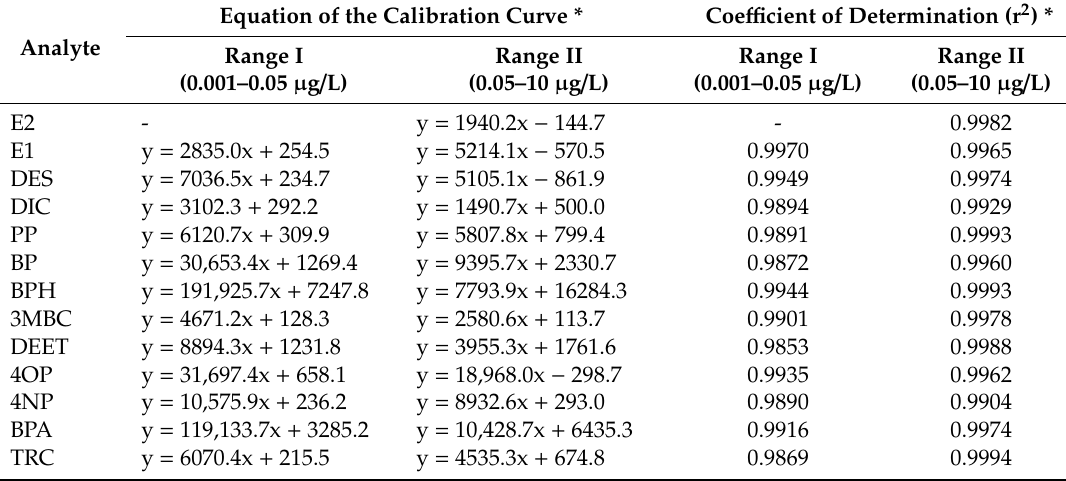
Table 3. Overview of the method’s linearity studies.